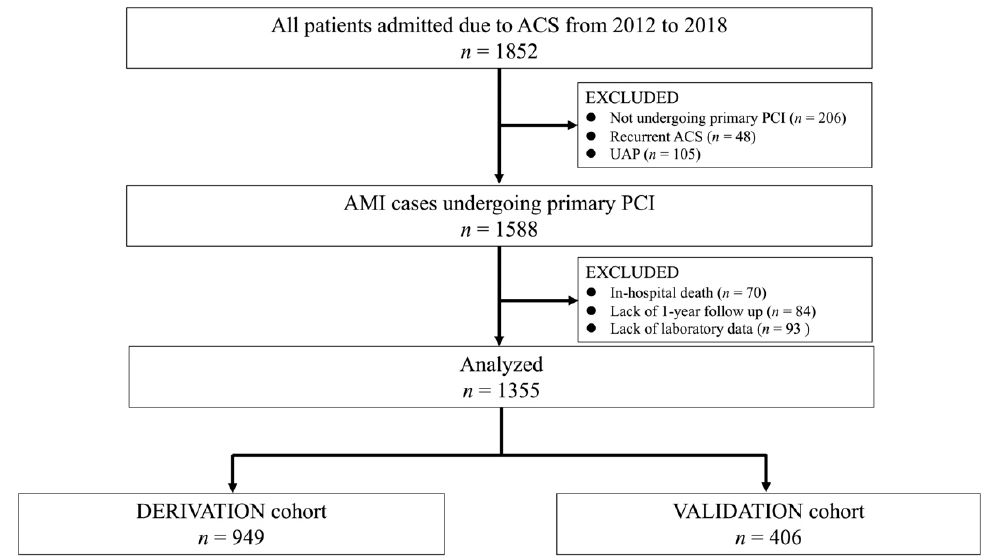
Figure 1. Flow chart of study participant selection. ACS, acute coronary syndrome; PCI, percutaneous coronary intervention; UAP, unstable angina pectoris.